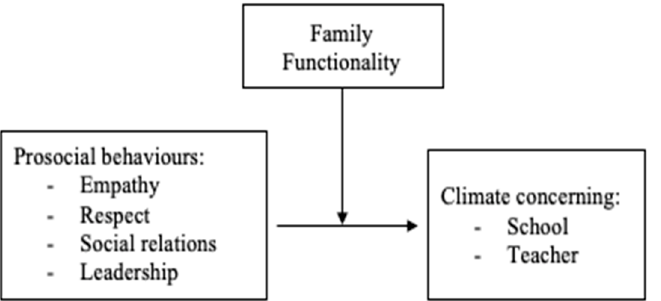
Figure 1. Hypothetical model of the moderation of Family Functionality in the relationship between Prosocial Behaviour and School/Teacher Climate. Prosocial Behaviour and School/Teacher